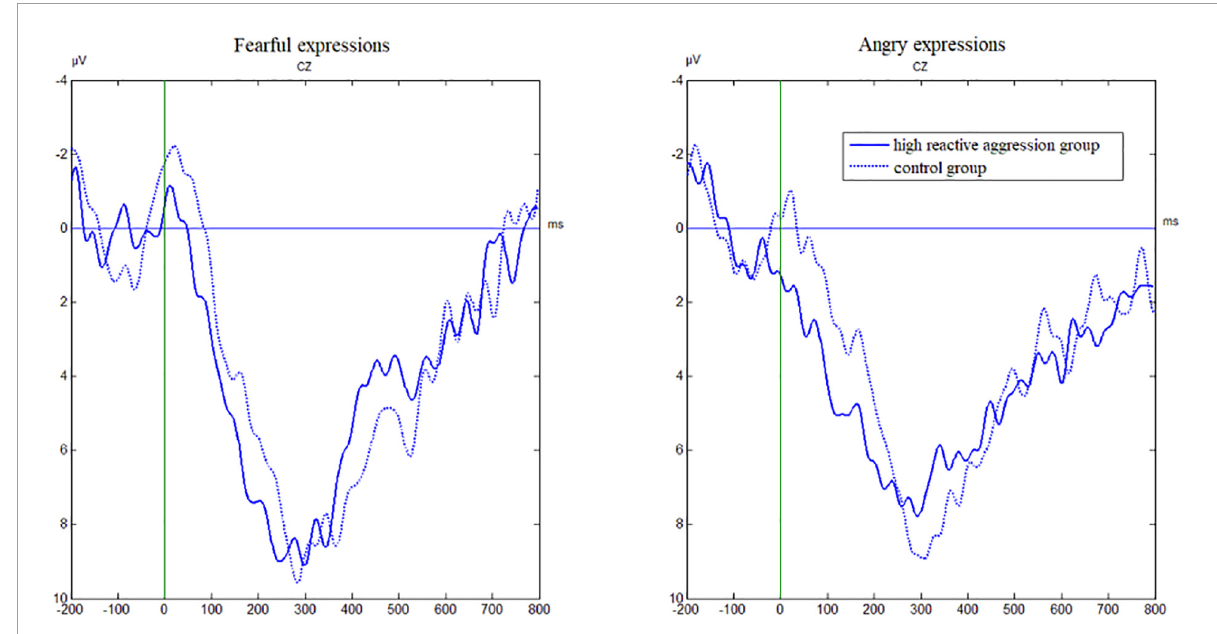
FIGURE4 Grand average waveforms from Cz evoked by the emotion for incorrect No-Go trials in the emotional Go/No-Go task as a function of group.